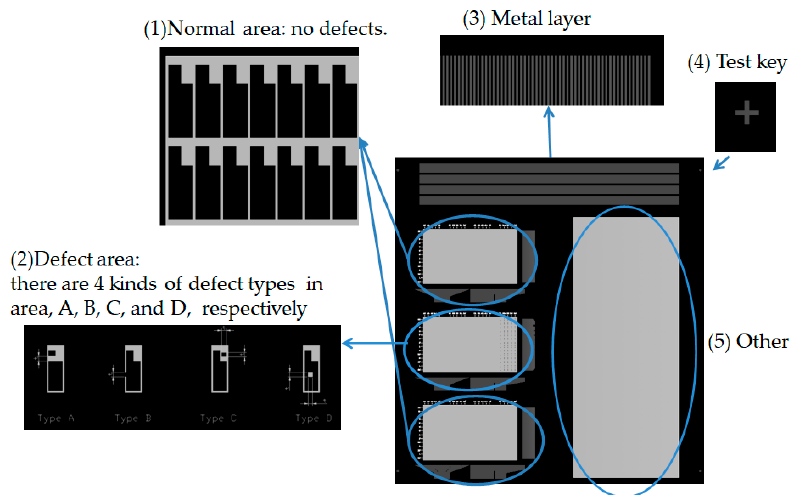
Figure 10. The architecture of the standard quartz mask is ready for line-scan detectability: (1) the normal area; (2) the defect area; (3) the metal layer; (4) the test key; and (5) other .